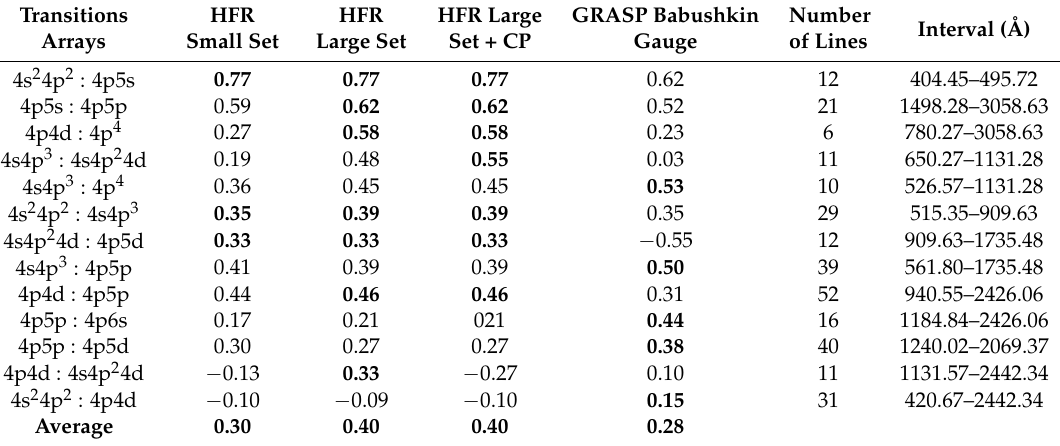
Table 2. Statistical correlation between log 10 gA and experimental line intensity. Maximum correlation for each transition array in boldface. Reproduced with permission from [53]. (© IOP Publishing. All rights